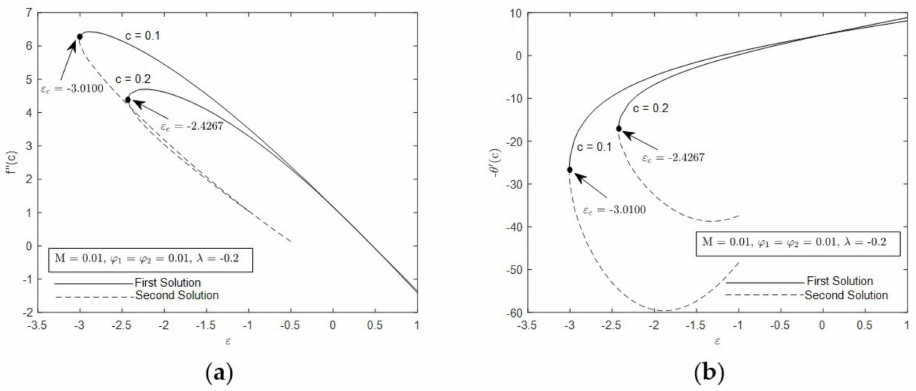
Figure 3. ( a ) Variation of f (cid:48)(cid:48) ( c ) velocity ratio parameter, ε for different values of c . ( b ) Variation of θ (cid:48) ( c ) with velocity ratio parameter, ε for different values of c . −